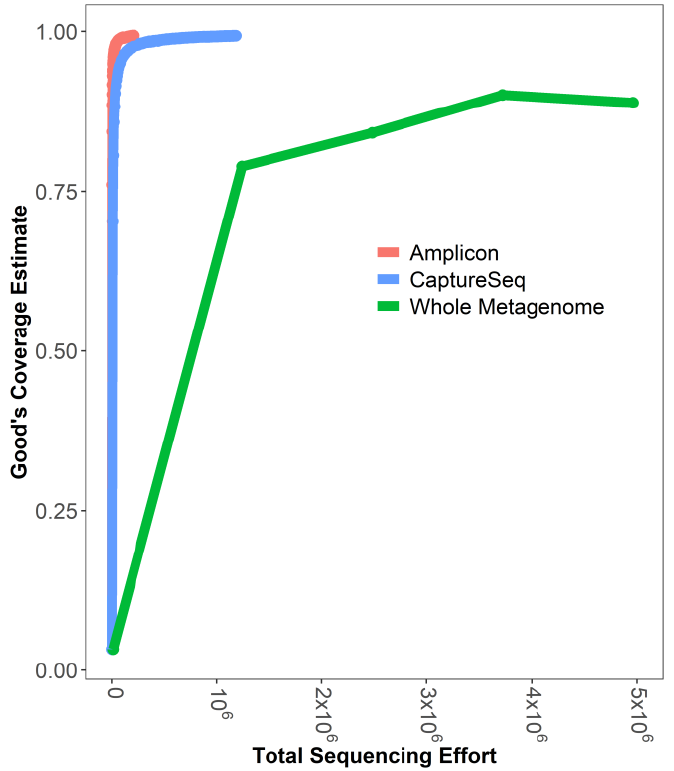
Figure 4. Good’s coverage estimate as a function of the average total sequencing effort for six soil samples each profiled using amplicon (red), CaptureSeq (blue), or shotgun metagenomic (green) approaches.